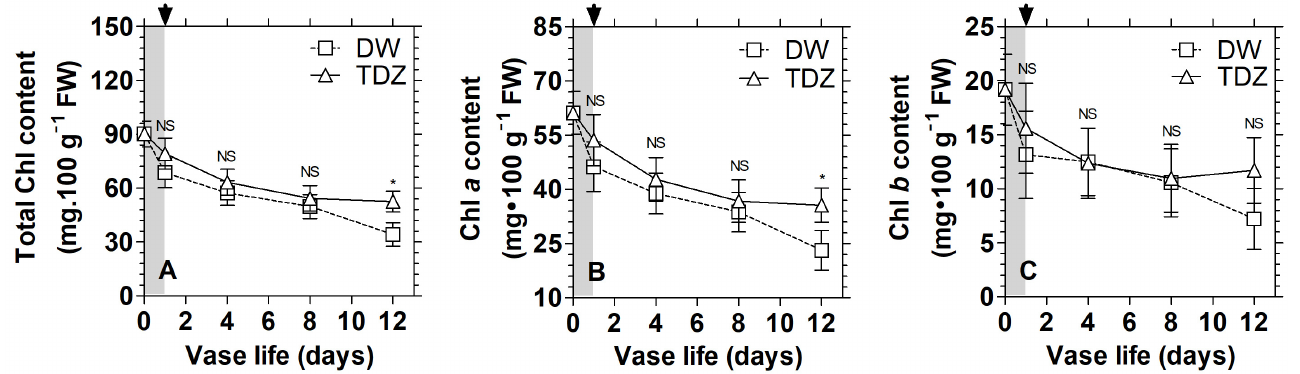
Figure 8. Effect of TDZ and MAP on the contents of total Chl ( A ), Chl a ( B ) and Chl b ( C ) in D. solida leaves after 1-week storage. Leaves were pulsed with 10 µ M TDZ and distilled water (DW; control), then packed in BOPP bag, and stored at 10 °C under cool-white fluorescent lights for 12 h/d for 1 week. After storage, ferns were transferred to distilled water in a controlled environment room for the vase period. Asterisks (*) indicate significant differences between the two treatments after storage ( t -test; * p < 0.05, ns not significant). The black arrow indicates the initial day in the vase. The yellowing ranged between 4 and 9% in the control leaves and those treated with TDZ on the initial day after storage, and increased continuously to 73 and 63%